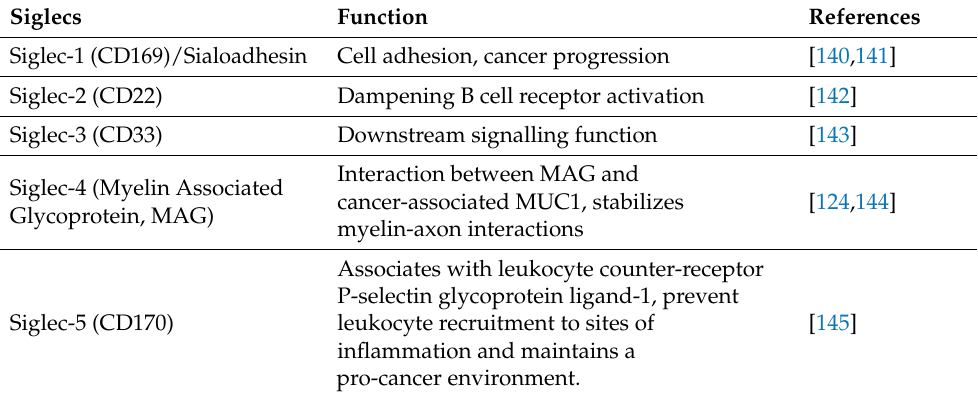
Table 1. Sialic acid-binding immunoglobulin-like lectins (Siglecs) and their function.